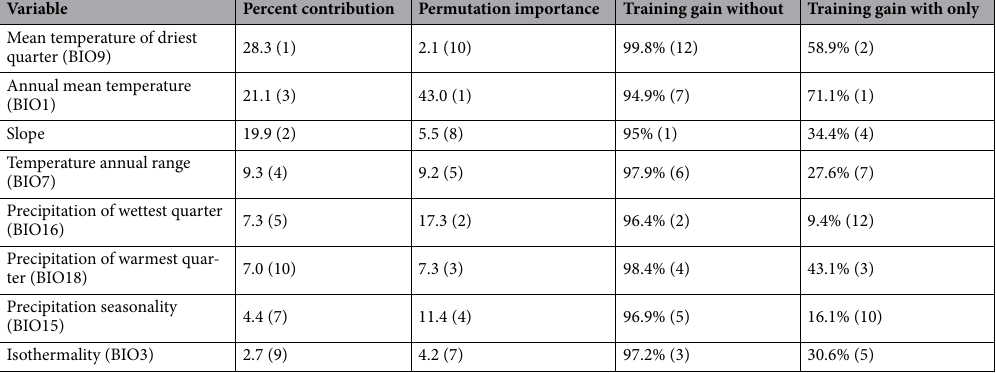
Table 1. Percent contribution, permutation importance and gain for the environmental variables included in the model. In parenthesis the rank of the variable contribution/importance in the model fitted with the whole set of 12 variables. Training gain values correspond to ratios relative to the full